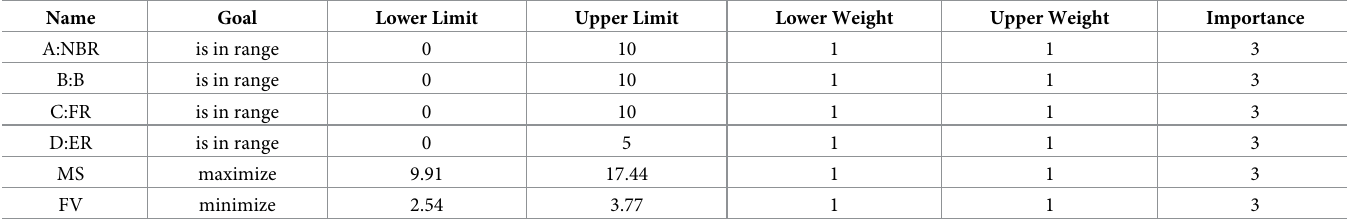
Table 9. Constraints utilized for multi response